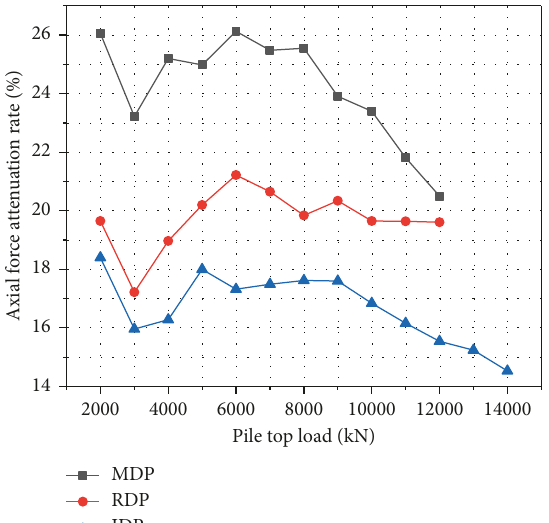
Figure 10: The axial force attenuation rate of test piles.